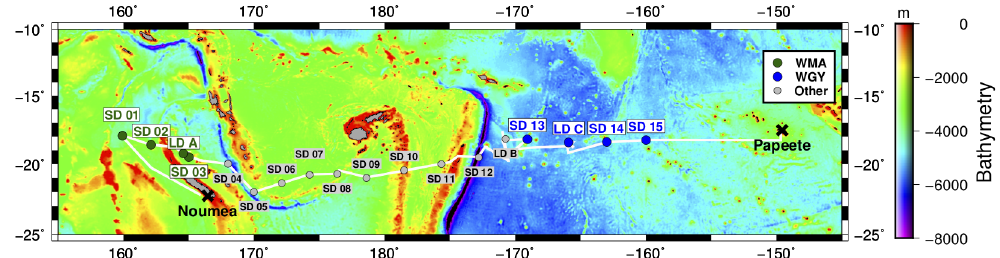
Figure 2. Transect of the OUTPACE cruise with the location of the SD and LD stations superimposed on a bathymetry map (GEBCO_2014 grid). The two main regions studied in this work are shown in green for the WMA and in blue for the